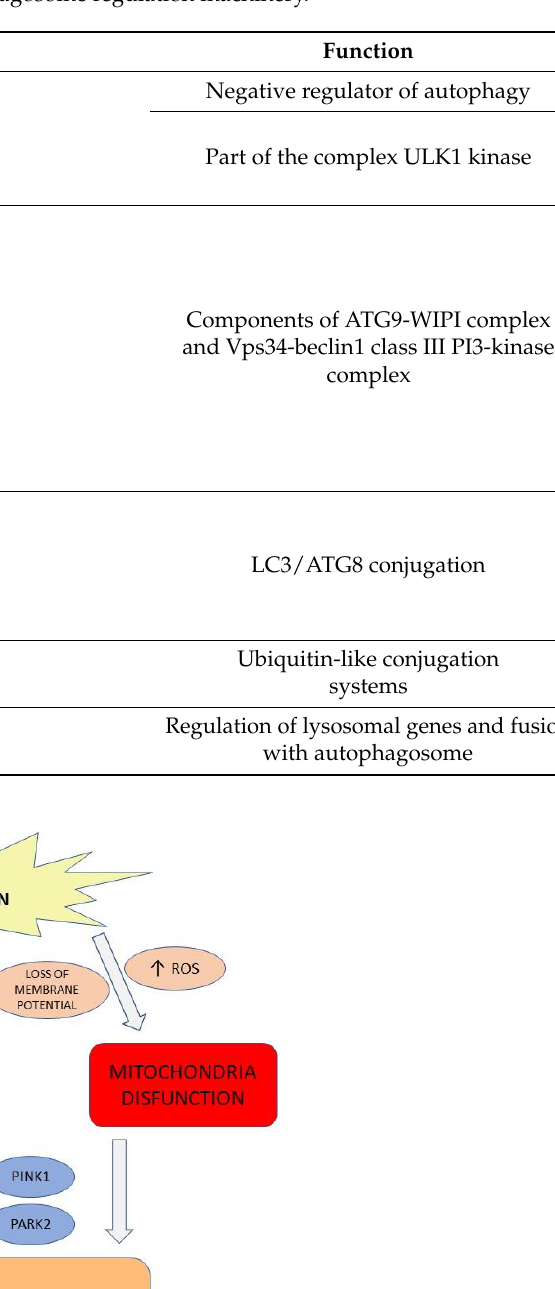
Table 1. Main genes involved in autophagosome regulation machinery.